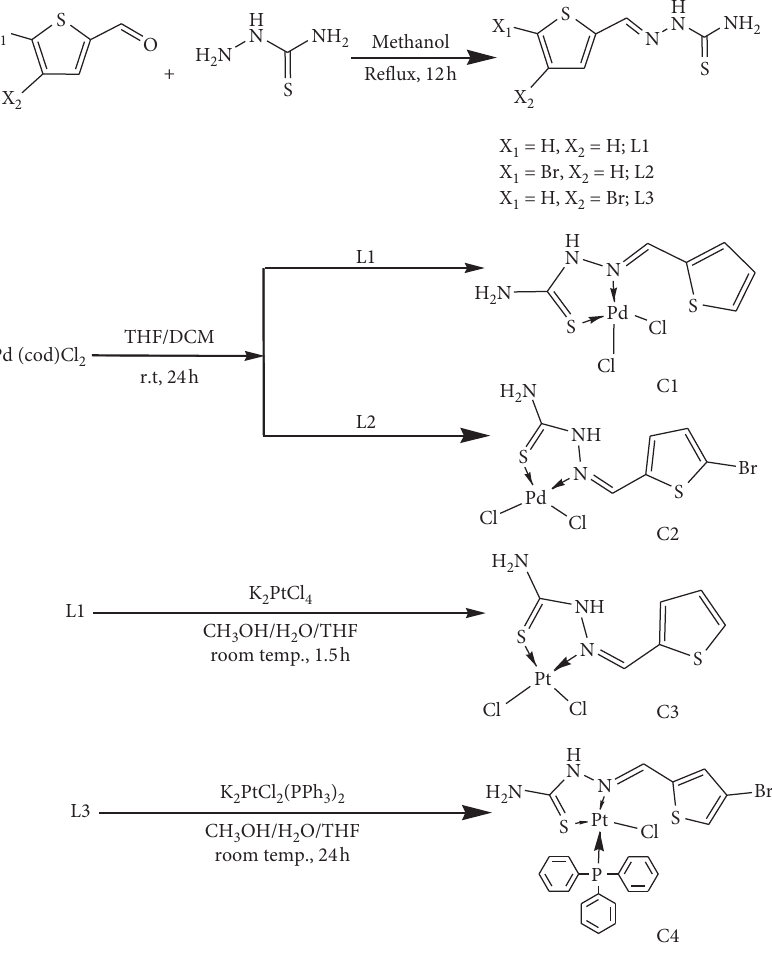
Scheme 1: Synthesis of Pd (II) and Pt (II) complexes.